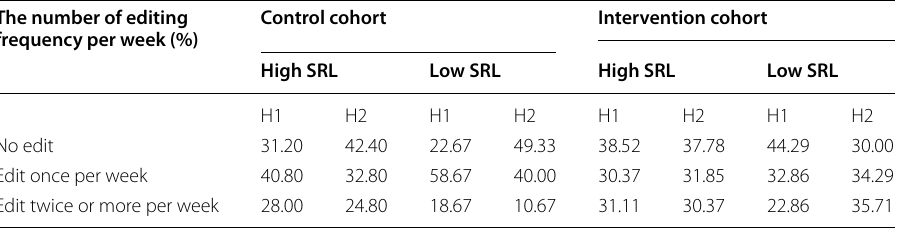
Table 4 The number of editing frequency per week (%) among clusters